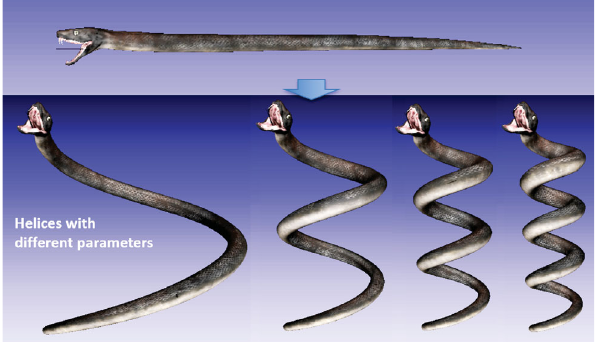
Fig. 11 A snake deformed into helices with different parameters. The densely-sampled centerline lies precisely on a mathematical helix. It is easy to impose precise curvature control using our method.